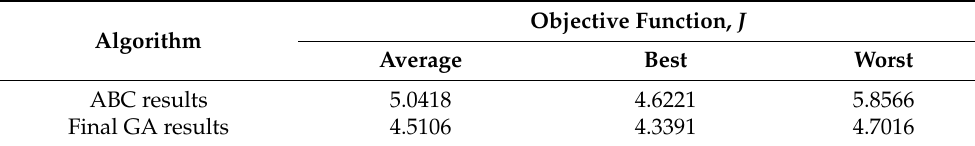
Table 5. Performance of ABC-GA hybrid